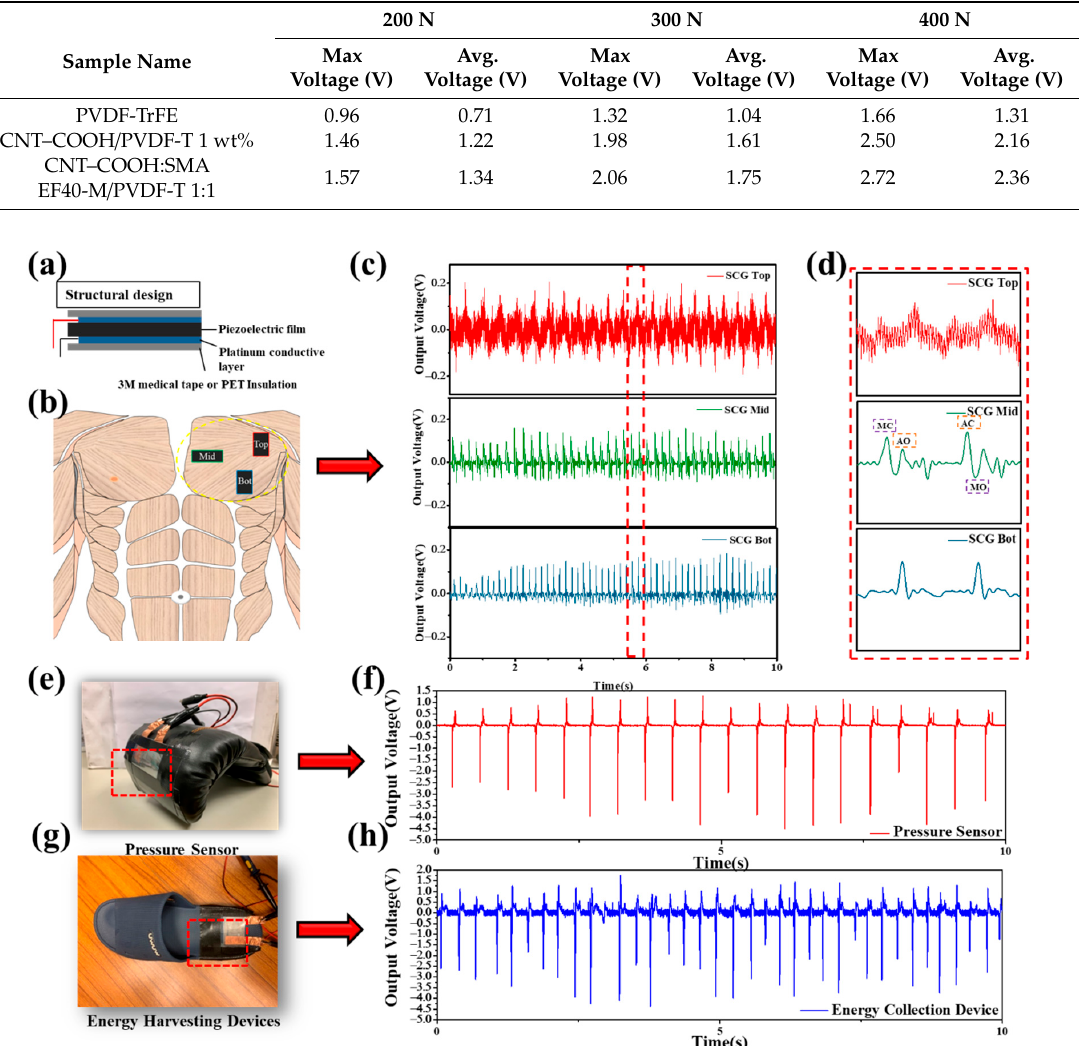
Figure 7. ( a ) Schematic of the CNT–COOH:SMA EF40-M/PVDF-T packaged sensing element, ( b ) schematic of the seismocardiography measurement positions, ( c ) measurement seismocardiography curves at different positions, and ( d ) partial enlarged view of the seismocardiography measurement at different positions. ( e ) Schematic of the pressure sensor and ( f ) measurement curves of the pressure sensor. ( g ) Schematic of the energy collector and ( h ) measurement curves of the energy collector.